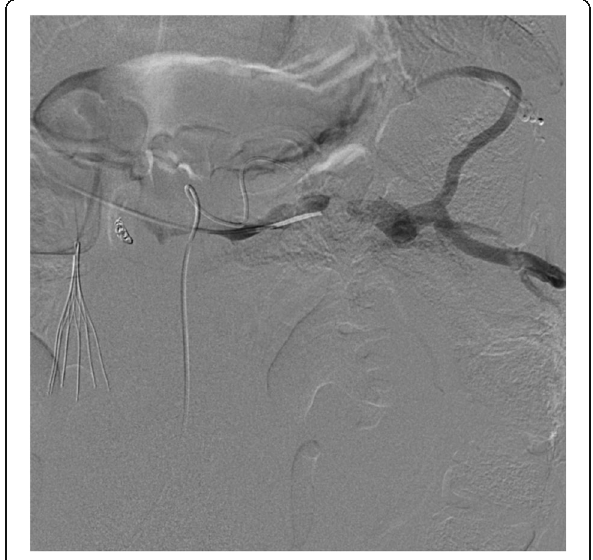
Fig. 1 Digital subtraction venography of the splenic vein prior to venoplasty reveals multiple areas of stenosis and robust venous collaterals from portal